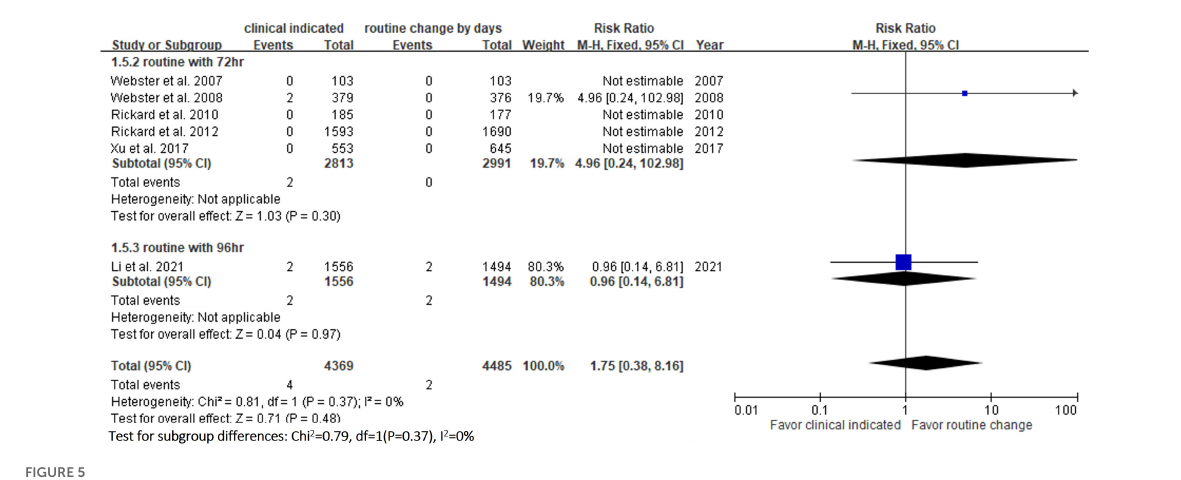
FIGURE5 Forest plot of the risk of infiltration.